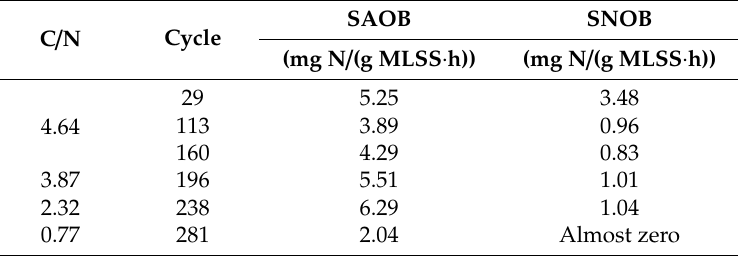
Table 1. The maximum activities of ammonia oxidation bacteria (AOB) and nitrite oxidation bacteria (NOB) at di ff erent C / N ratios.